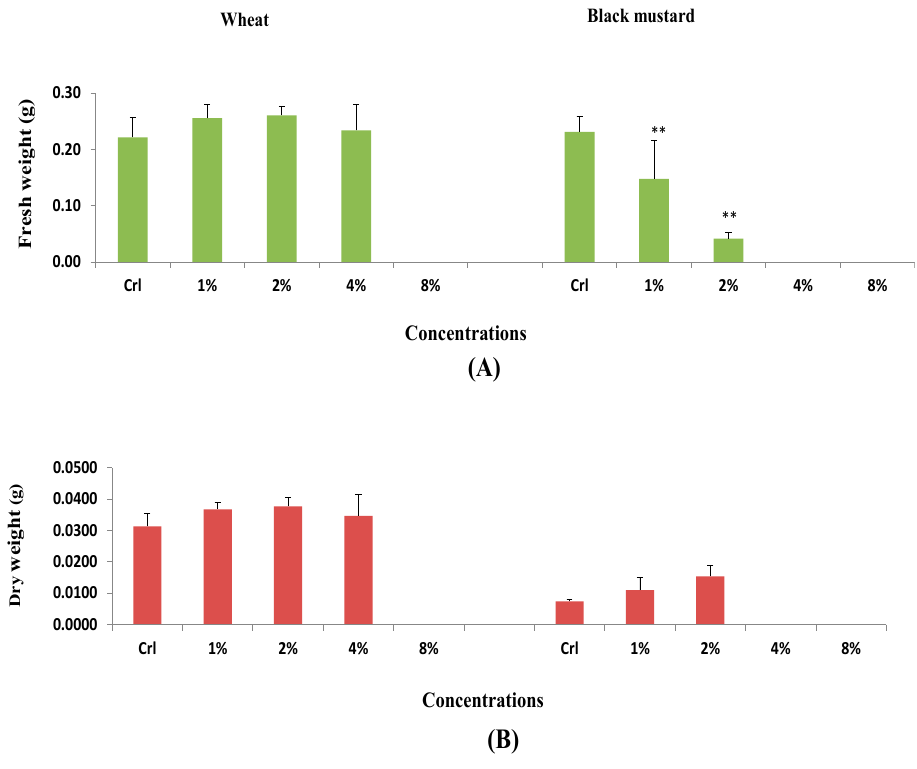
Figure 4. Effect of the aqueous extract of H. persicum on seedling fresh weight ( A ) and dry weight ( B ) in wheat and black mustard. ** = highly significant. Crl =